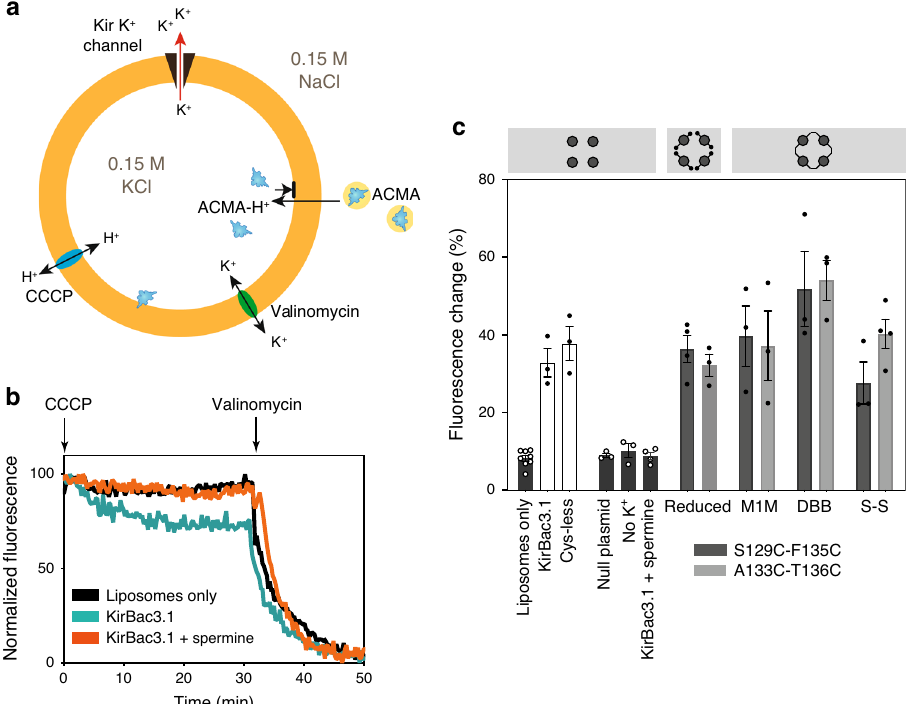
Fig. 4 Potassium permeates through crosslinked KirBac3.1. a A lipid-soluble proton-sensitive dye (9-amino-6-chloro-2-methoxyacridine, ACMA) is equilibrated with proteoliposomes (orange circle) prior to addition of a protonophore (carbonyl cyanide m-chlorophenylhydrazone, CCCP). Protons in fl uxing through CCCP bind ACMA, which manifests as a decrease in fl uorescence emission and is balanced by K + ef fl ux through the K + channel. Protonated ACMA cannot pass out through the membrane. Limiting fl uorescence is determined by addition of the K + ionophore valinomycin. The total fl uorescence change measured in the assay is summed from individual proteoliposomes. b Normalized raw data from wild-type channels. c Summary of potassium fl ux experiments. Data shown as mean ± SEM ( n = 8 (channel-free)), 3 (wild-type, Cys-less, null plasmid, no K + , A133C-T136C reduced, S129C- F135C MTS-1-MTS, A133C-T136C MTS-1-MTS, S129C-F135C dibromobimane, A133C-T136C dibromobimane, S129C-F135C disul fi de), 4 (wild-type spermine block, S129C-F135C reduced, A133C-T136C disul fi de experiments); details of replicates are in Supplementary Table 4. Each black or white circle represents the mean from an individual experiment. Liposomes only = reconstituted with buffer-only; KirBac3.1 = wild type; Cys-less = KirBac3.1 (C262S, C71V, C119V); No K + = (Na + i /NMDG + o /ionophore = monensin); KirBac3.1 + spermine (500 i /1000 o μ M). M1M = mts-1-mts; DBB = dibromobimane; S – S = disul fi